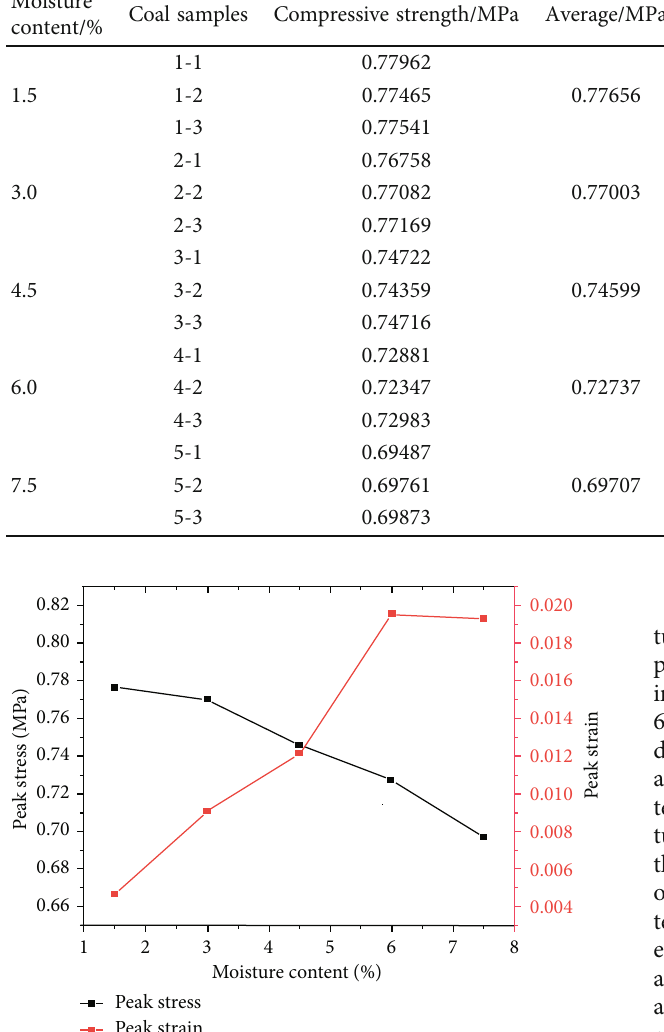
Moisture content/%